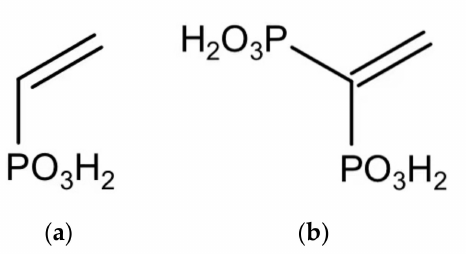
Figure 4. Phosphorus based vinylic monomer species: ( a ) VPA and ( b )